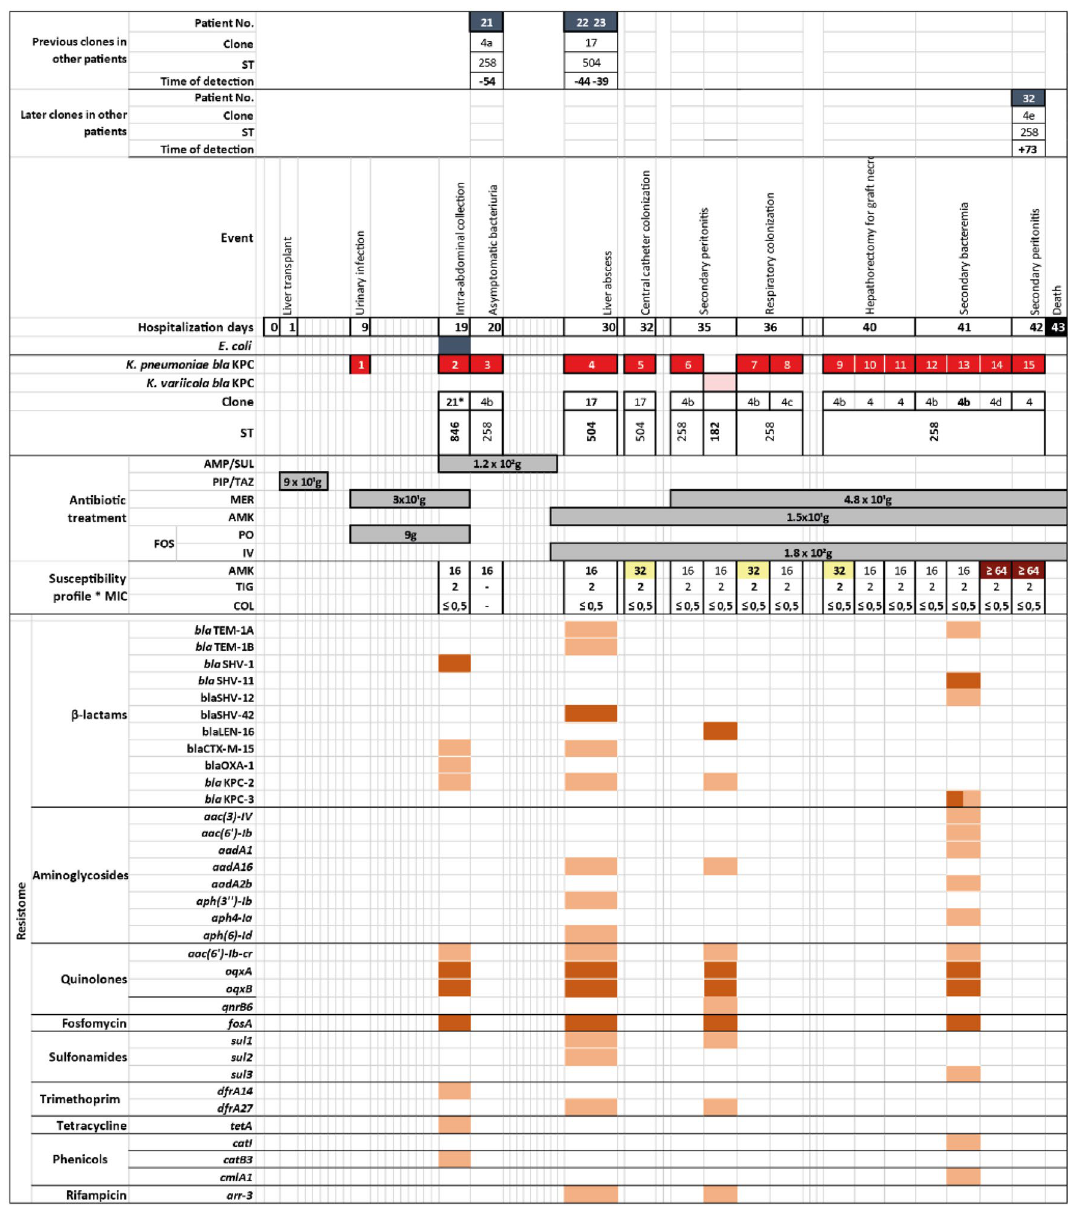
Figure 2. Analysis of the circulation dynamics of KPC- Kp clones of patient number 24 during antibiotic treatment in the hospital stay in 2015. The graph illustrates to scale the timeline from the admission of the patient to the institution (day 0) until death (day 43), with a description of the events associated with the KPC-producing K. pneumoniae (KPC - Kp) isolates 33Kpn9, 33Kpn12 and 33Kpn22 which were red colored respectively; and a pink box for KPC-producing K. variicola (KPC- Kv ) isolate 33Kva16, with their respective MLST. Regarding the susceptibility profile, only the antibiotics to which the isolates were susceptible were illustrated, within the boxes the value in white, yellow and dark red of the minimum inhibitory concentrations (MIC) corresponding to the range of the points of inhibition are described. CLSI cutoffs: susceptible, intermediate, and resistant, respectively. The type of antibiotic used with the cumulative dose in grams and the days of duration of treatment are described in gray boxes. Regarding the resistome of the sequenced isolates, the genes present were organized considering the type of antibiotic and shaded in light orange if they had plasmid location and in dark if it was chromosomal, chromosomal encoded beta-lactamase bla SHV or bla LEN were not shown. Finally, the connection with other patients who presented the same clone and the number of previous (−) or later (+) days of difference are